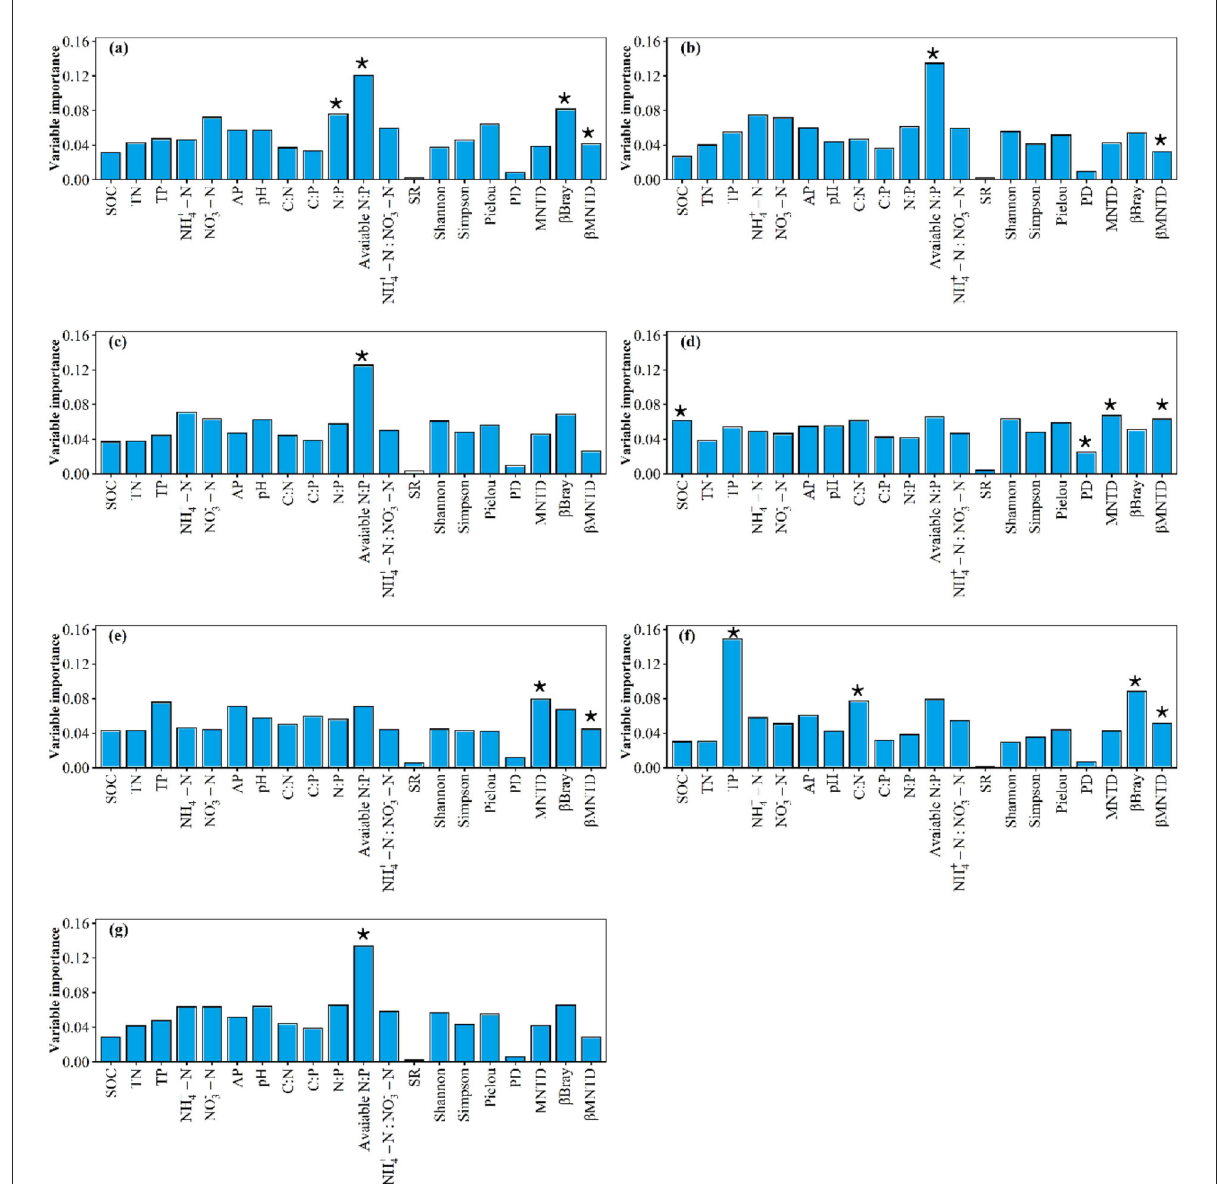
FIGURE7 The relative contributions of α - and β -diversity of high-quality forage and soil variables for high-quality forage (a) crude protein storage, (b) acid detergent fiber storage, (c) neutral detergent fiber storage, (d) ether extract storage, (e) crude ash storage, (f) water-soluble carbohydrates storage, and (g) nutrient storages, respectively. * indicates p <